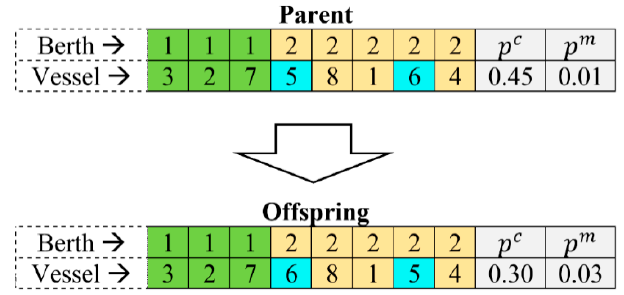
Figure 7. An example of the SAEA mutation operation: swap + floating point.